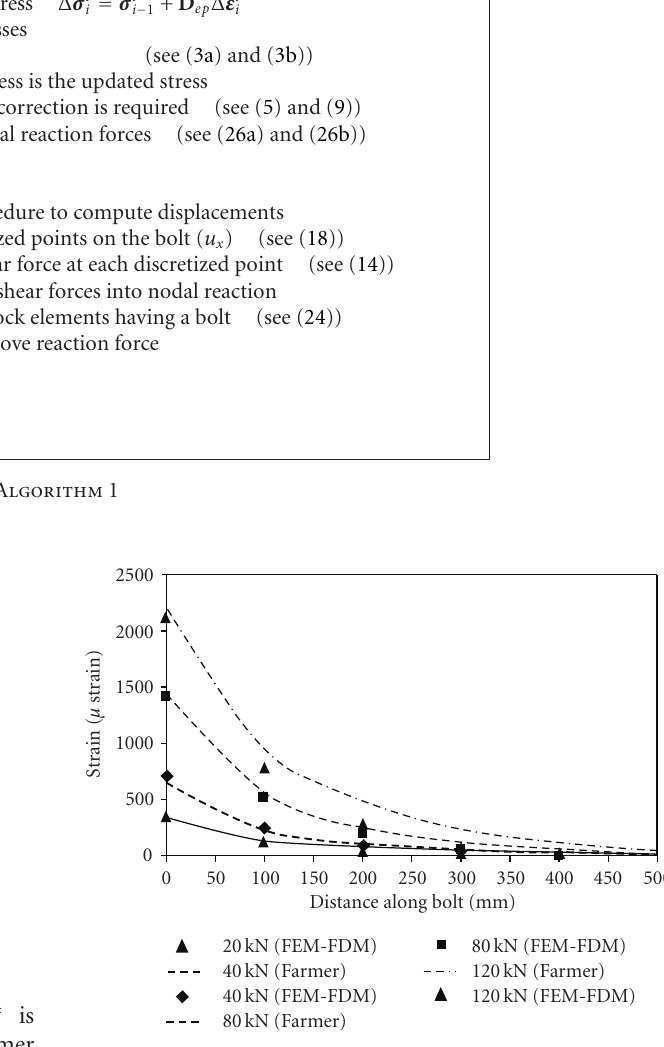
Figure 7: Distributions of strain along the bolt